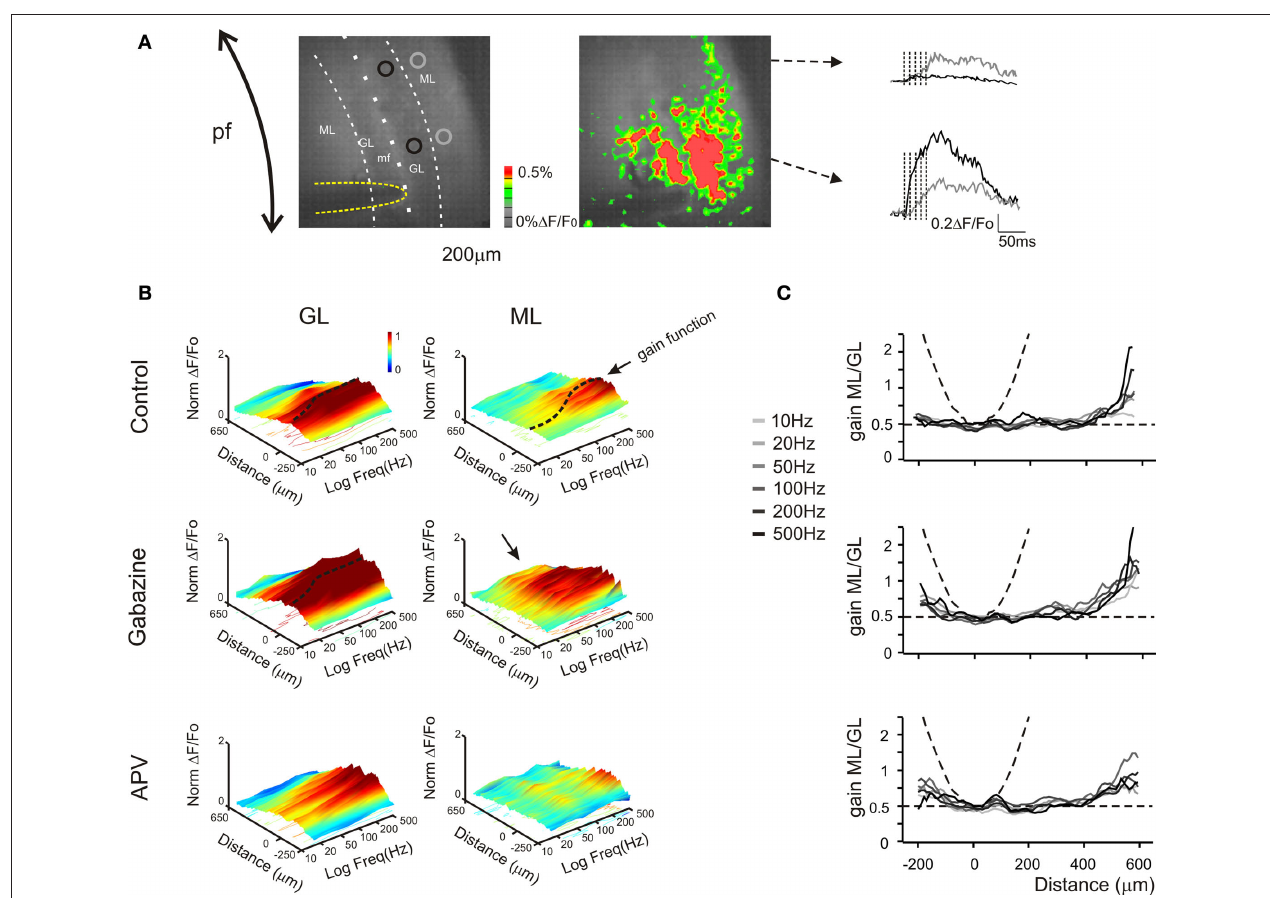
FiGure  | Granular and molecular layer activation in coronal slices. (A) Optical maps obtained at the peak of responses in five pulses 100 Hz burst delivered to the white matter (yellow line surrounds the stimulation electrode), in coronal slices. The molecular layer signal propagates beyond the corresponding granular layer activated area, activating distal areas of the molecular layer The traces illustrate the time course of different regions (black and gray circles) of the granular (black trace) and molecular layer (grey trace). Note that the molecular layer response proximal to the core of the granular layer activation is slower and smaller than the corresponding granular layer response, while in distal regions the molecular layer signal overcomes the almost absent granular layer response (as evidenced from the optical map). (B) The spatial profile of gain was measured for different frequencies burst both in the granular and in the molecular layer ( n = 4 slices, for each frequency). 3D maps show the spatial distribution of gain functions in different experimental conditions (Control, Gabazine and APV), evidencing the space ( x ) and frequency ( y ) dependence of granular and molecular layer activation ( z ). Dashed lines indicate gain functions in the core of the granular and molecular layer activation (cfr Figures – ). The spatial profile ( x -axis) of the granular layer activation is narrow around the stimulating electrode (0 reference) and decays in distal regions, maintaining this profile even increasing the stimulation frequency. Conversely the excitation profile of the molecular layer shows the activation of the periphery for all tested frequency, while the core of excitation shows a strong dependence on the stimulation frequency. The